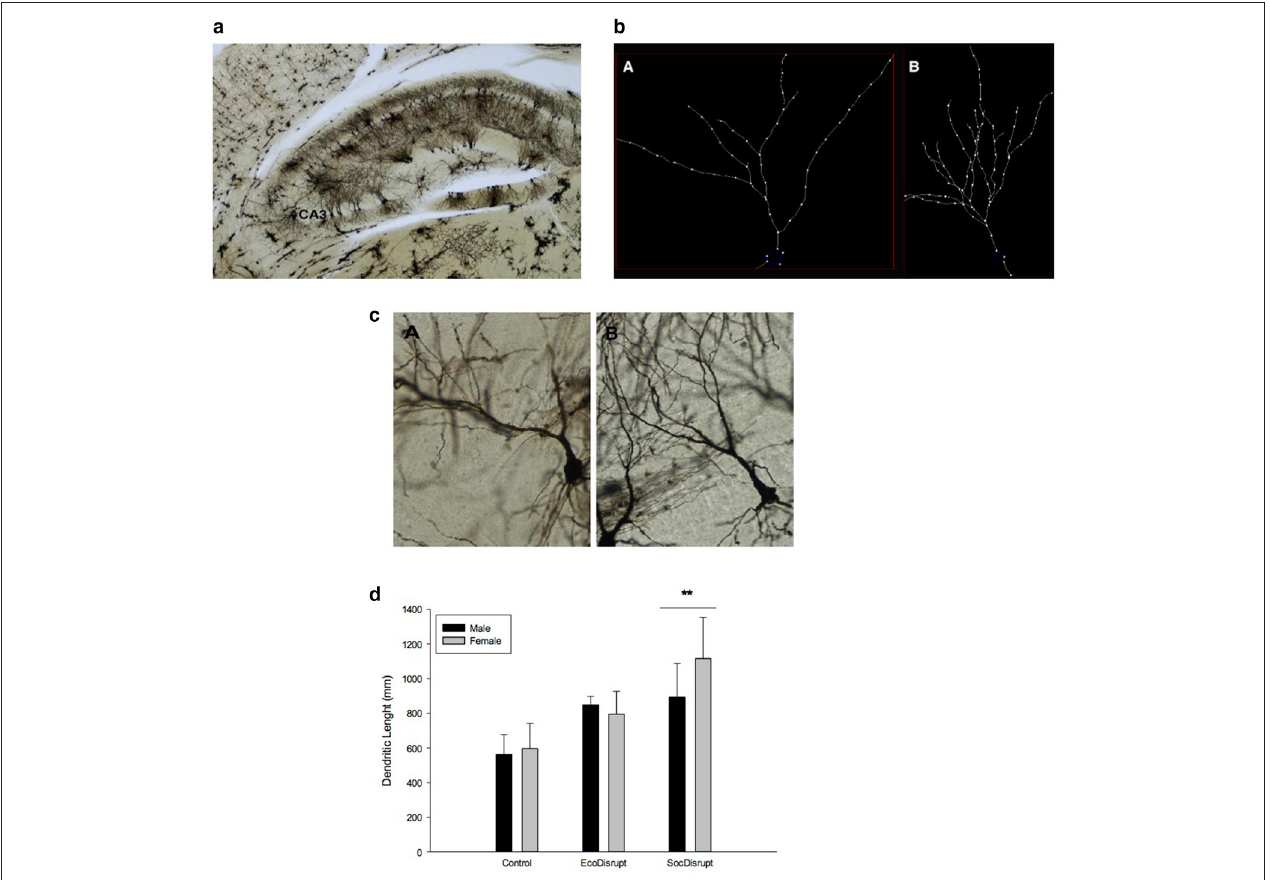
FIGURE 2 | (a) Photomicrograph showing CA3 area of the hippocampus of a prairie vole prepared with Golgi Stain. (b) Reconstructed CA3 neuron in the hippocampus showing the apical dendrites in a representative animal from (A) Control and (B) SocDisrupt group. (c) Photomicrograph of the CA3 neuron in the hippocampus showing the apical dendrites in a representative animal from (A) Control and (B) SocDisrupt group. (d) Group differences in apical dendritic length of neurons in the CA3 region of the hippocampus. The conditions were Control (adult offspring raised by both parents under a protective cover and housed with a same-sex partner after weaning), EcoDisrupt (adult offspring raised by both parents without a protective cover and housed alone after weaning); SocDisrupt (adult offspring raised by mother alone with a protective cover and housed alone after weaning). The bars show means ± SE and **over the bars indicate significant group differences at p <